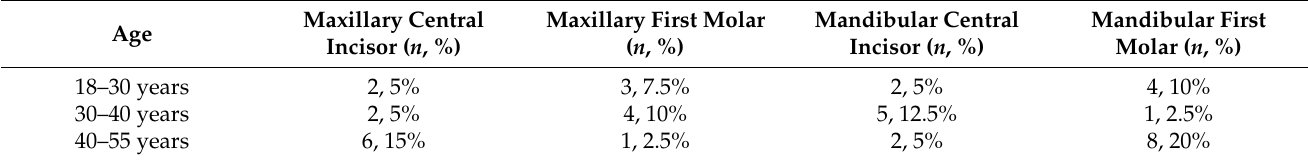
Table 1. Numbers of patients ( n = 40) and percentages (%) in each of the groups according to age. Maxillary Age